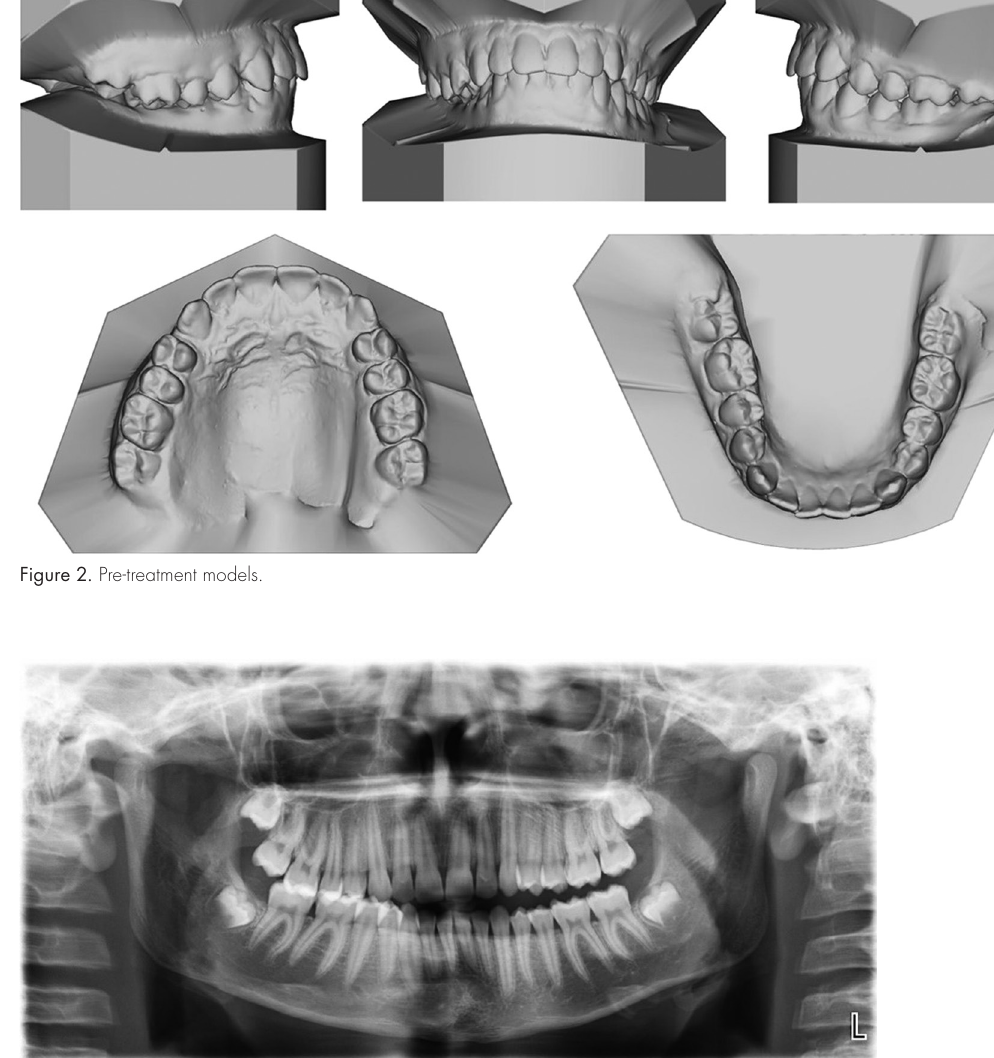
Figure 3. Pre-treatment panoramic